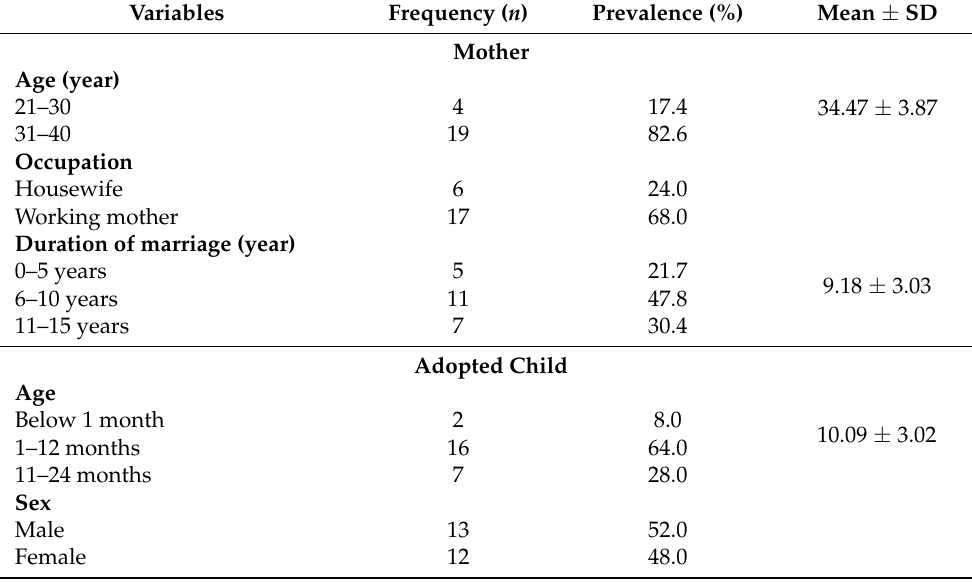
Table 2. Summary data for the respondents.